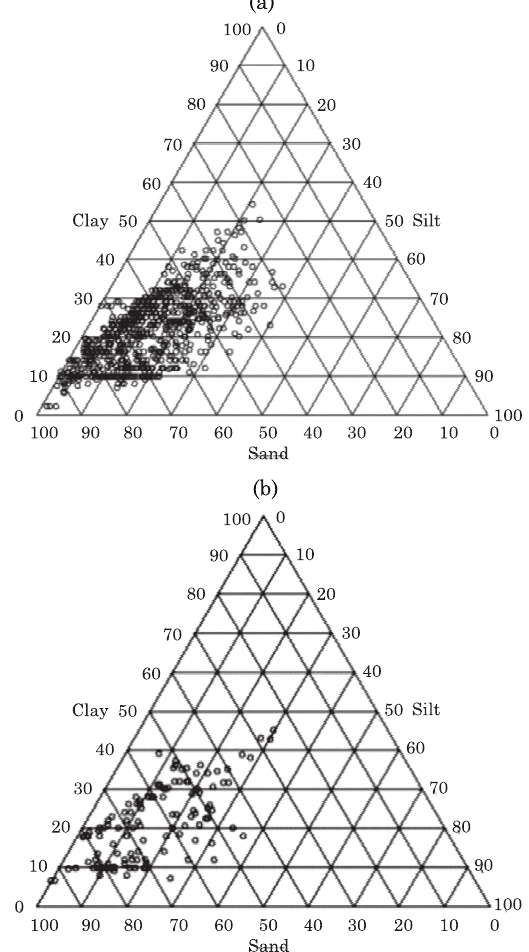
Figure 4. Textural properties of soil samples used for PTF development (a) and validation